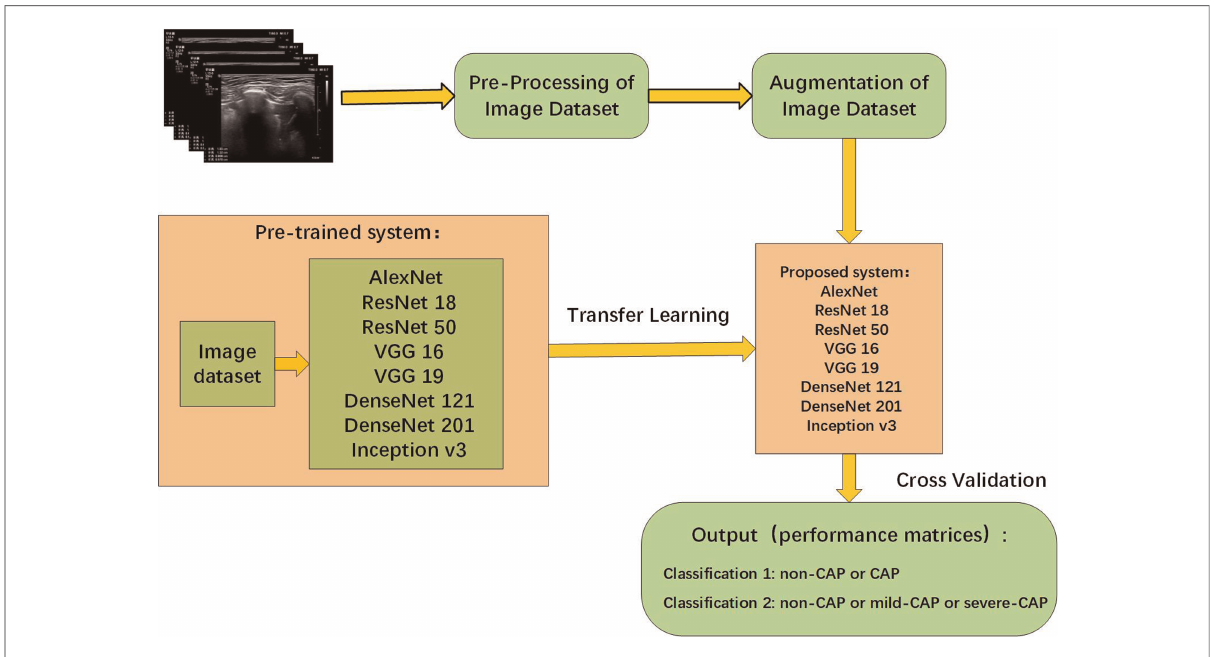
FIGURE 1 Framework for the detection of CAP and severity classi fi cation.